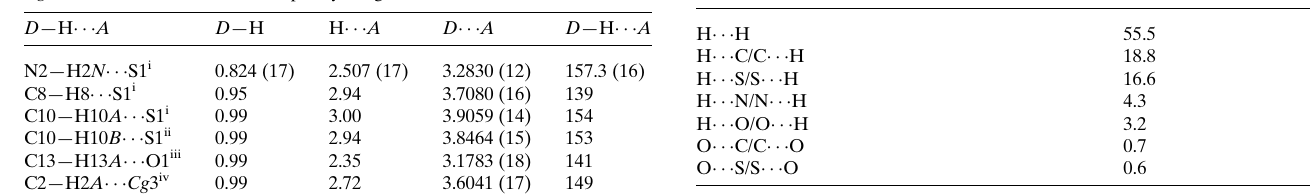
Table 1 Hydrogen-bond geometry (A˚ , (cid:3) ). Cg is the centroid of the C3–C8 phenyl ring.